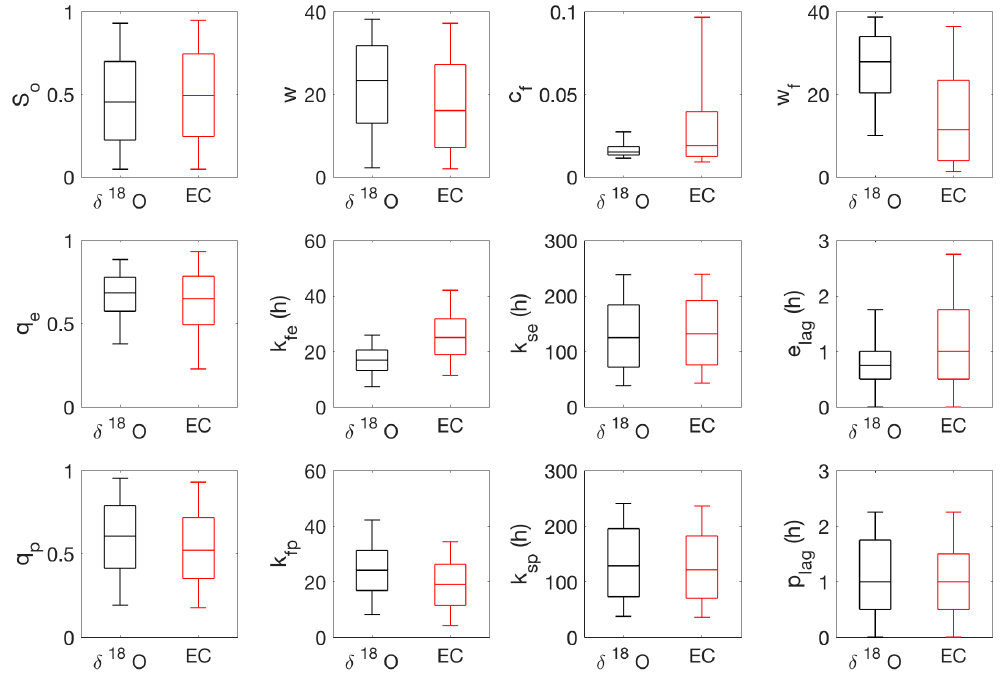
Figure 7. Box plots of the calibrated parameters considering sets that yielded NSE > 0.75 from the last run (i.e., 1 × 10 7 simulations) using model structure 4 calibrated for δ 18 O and electrical conductivity (EC) data. Parameter names are shown in Table 1.